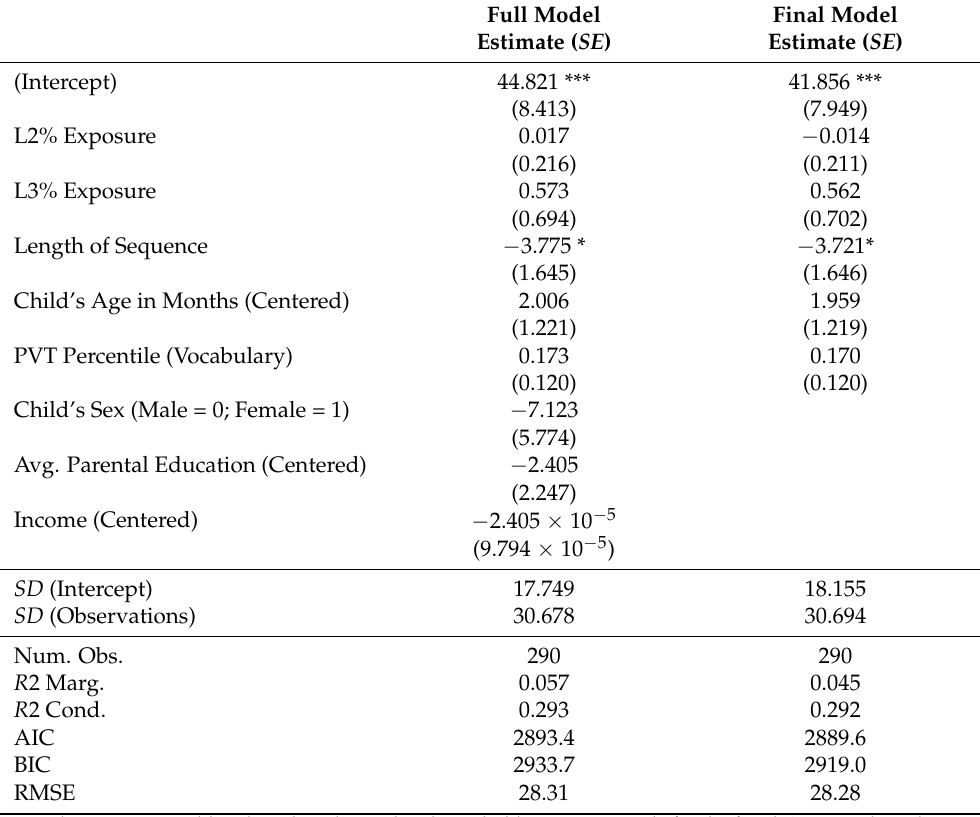
Table 8. Regression Models for Analysis Approach 3 -L2%